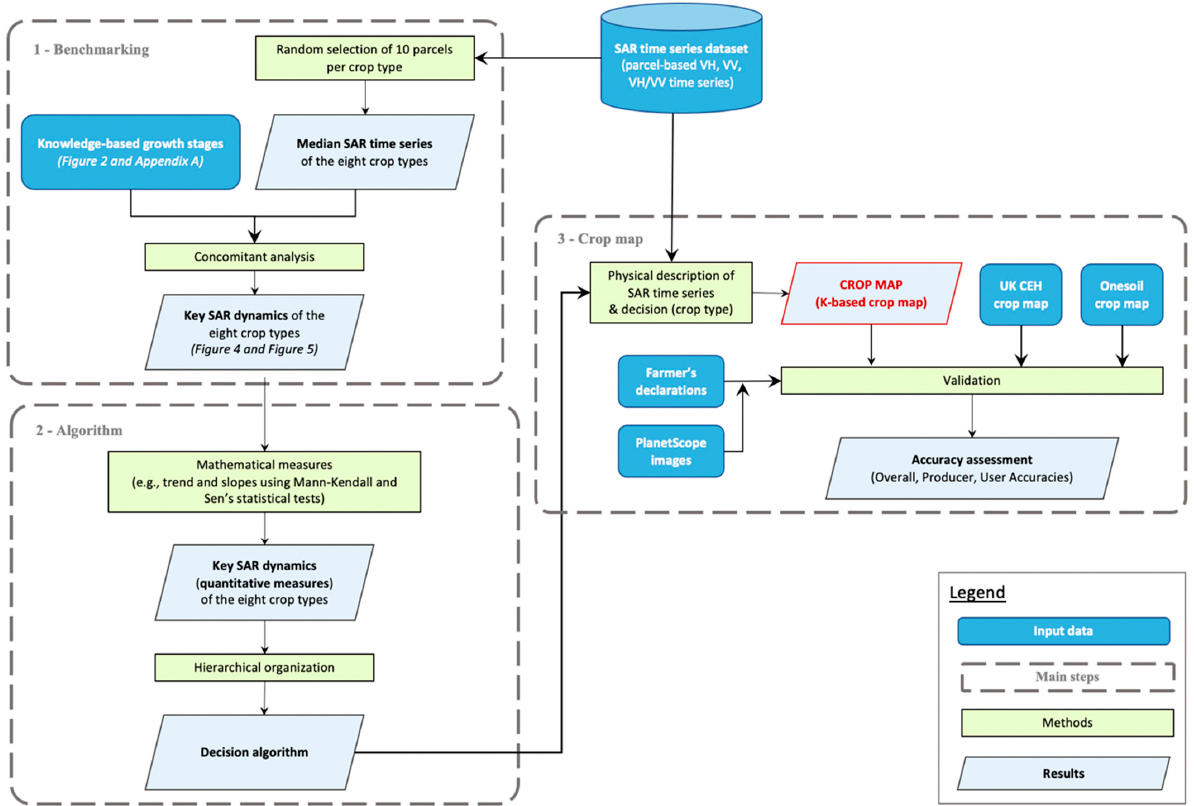
Figure 3. Flowchart of the methodology. Note: K-based crop map = knowledge-based crop map.